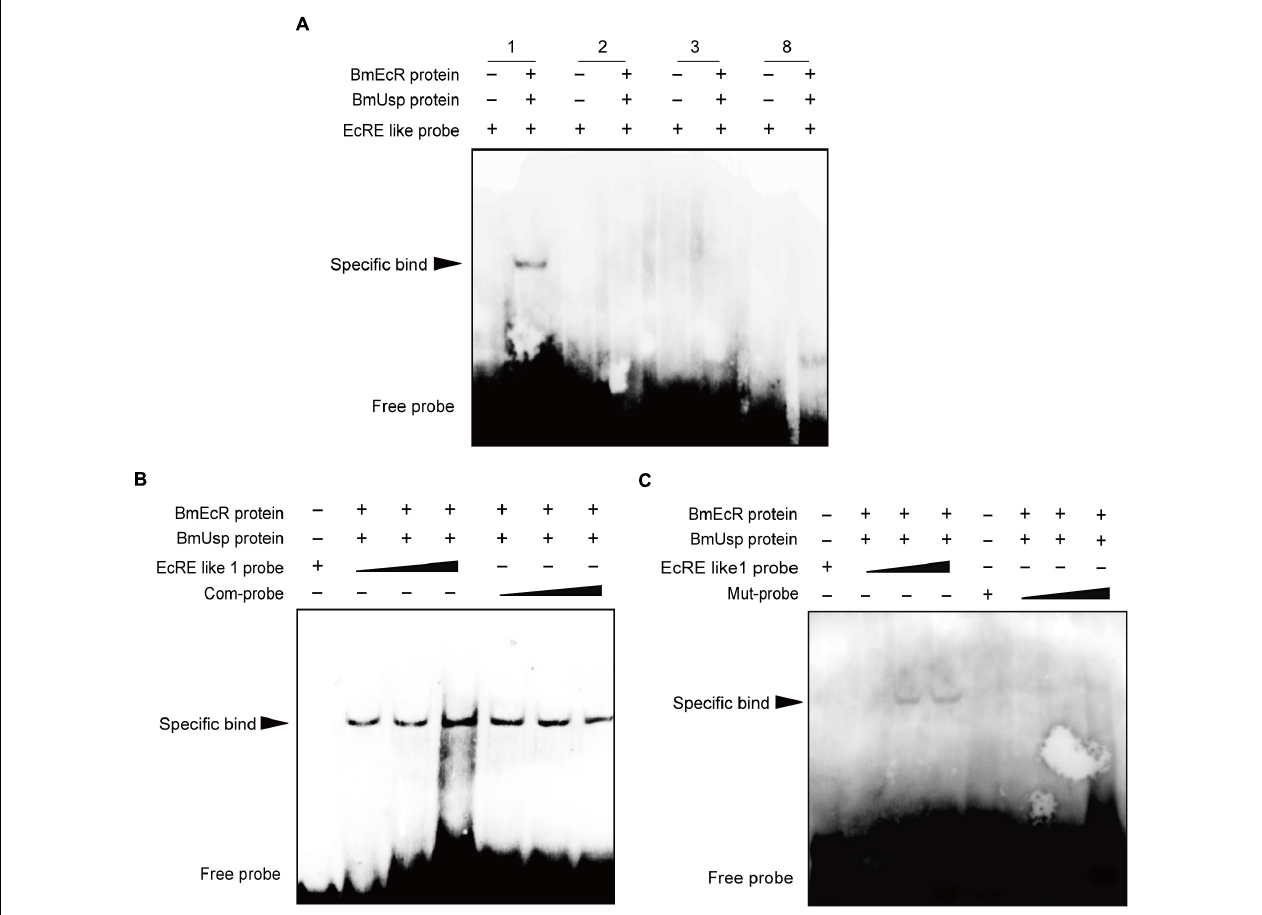
FIGURE 4 | Identification of EcRE on the Bombyx mori ERR ( BmERR ) promoter. (A–C) DNA-binding activity of EcRE-like 1/2/3/8 probes with purified BmEcR and BmUSP protein verified by electrophoretic mobility shift assay (EMSA). 1/2/3/8, biotin-labeled EcRE-like 1/2/3/8 probe. Com-probe is the biotin-unlabeled competition probe which is of the same sequence as EcRE-like 1. Mut-probe is the mutated biotin-labeled EcRE-like 1 probe. The final concentration of EcRE probe was 5 µ M, the concentration of BmEcR protein is 0.3 µ g/ µ L and the concentration of BmUSP protein is 0.45 µ g/ µ L. The ratio of EcRE probe to the competing probe is 1:10.